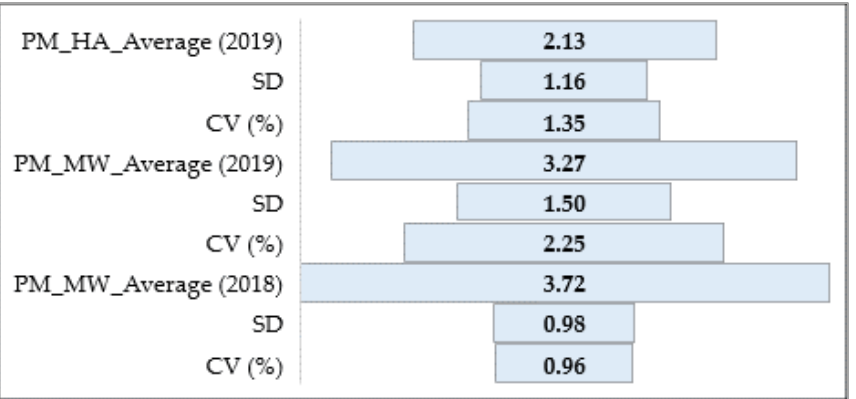
Figure 2. Summary data for powdery mildew (PM) severity on spring barley accessions phenotyped under field conditions in 2018–2019. Average value of disease severity, SD ( p ≤ 0.05) and CV (%) at the heading (PM_HA) and the milky-waxy (PM_MW) stages in 2019 and at the milky-waxy (PM_MW) stage in 2018. Disease severity was scored on the 1–9 scale (1 = immune